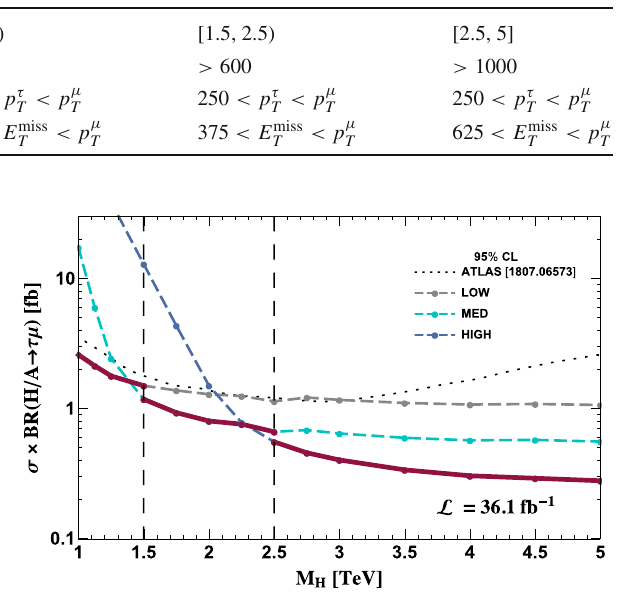
Fig. 3 95% CL exclusion limits in the [ M H , σ( pp → H / A → τμ) ] plane for the search strategies low (gray dashed line), medium (cyan dashed line), high (blue dashed line), and our global search strategy in the full mass range (maroon solid line), with L = 36.1 fb − 1 . Dashed vertical lines indicate the mass region for each analysis, see Table 2. The dotted line is the expected exclusion for a sneutrino (cid:2) ν → τμ search by ATLAS at L = 36.1 fb − 1